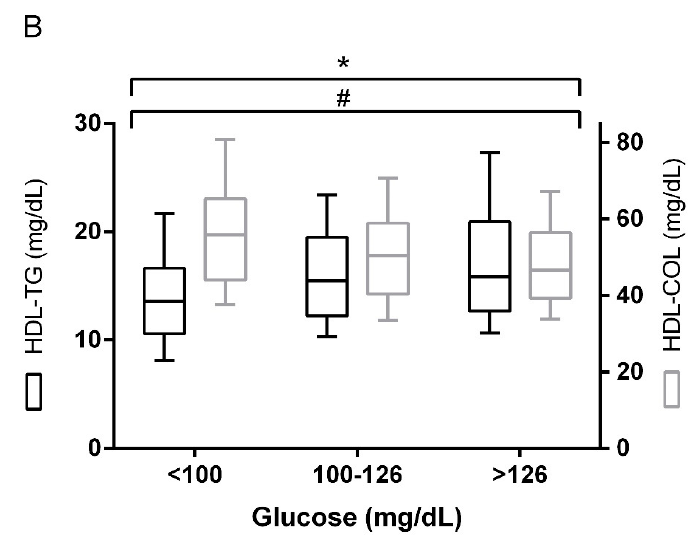
Figure 2. HDL-TG and HDL-C levels according to metabolic syndrome (MS) components ( A ) and diabetes status ( B ). The data are presented as box-plot. p values for group comparison are reported for the Kruskal–Wallis test. * p < 0.001 for the trend, HDL-TG; # p < 0.001 for the trend, HDL-C. MS components: 0 ( n = 32); 1 ( n = 42); 2 ( n = 77); 3 ( n = 126); 4 ( n = 139); 5 ( n = 86). Diabetes status: < 100 ( n = 112); 100–126 ( n = 134); > 126 ( n = 256).